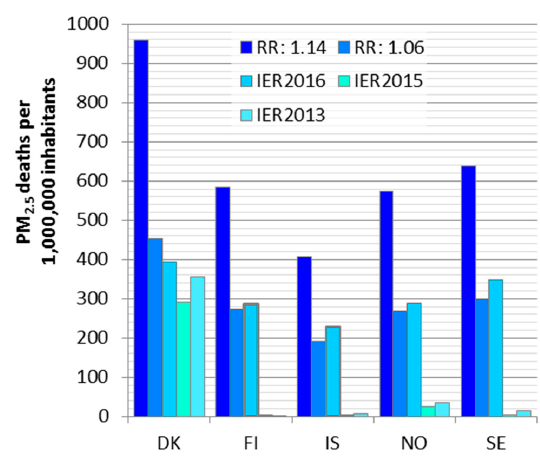
Figure 2. Deaths attributable to ( a ) PM 2.5 and ( b ) O 3 exposures in the Nordic countries per million